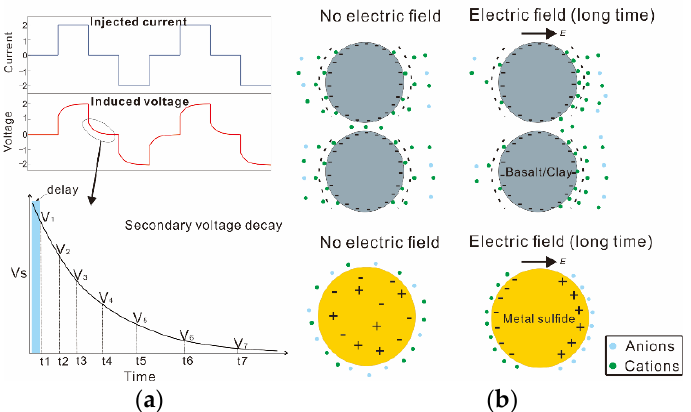
Figure 2. Sketch of TDIP measurement and the IP phenomenon. ( a ) Time-domain induced polariza- tion measurement. ( b ) Induced polarization effect of a metal sulfide grain and basaltic/clay grain in the electrolyte.